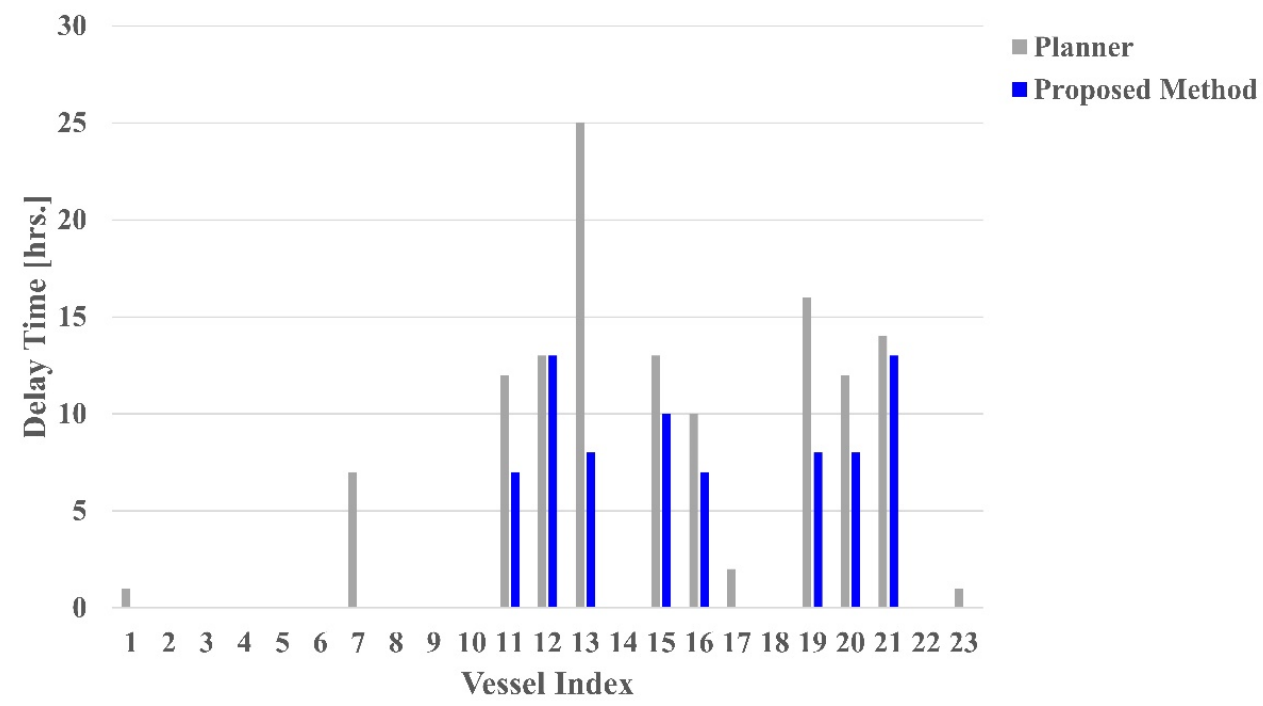
Figure 8. Departure delay time by vessel in Scenario 2.